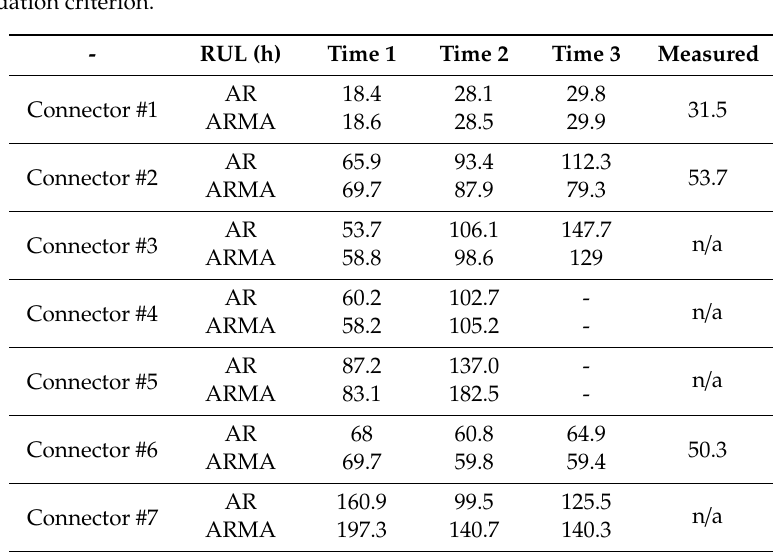
Table 1. Resulting remaining useful life (RUL) estimations for the seven electrical connectors under study considering autoregressive (AR) ( p = 3) and autoregressive integrated moving average (ARMA) ( p = q = 2) models. RUL estimations are carried out at three di ff erent service points according to the 40% degradation criterion.